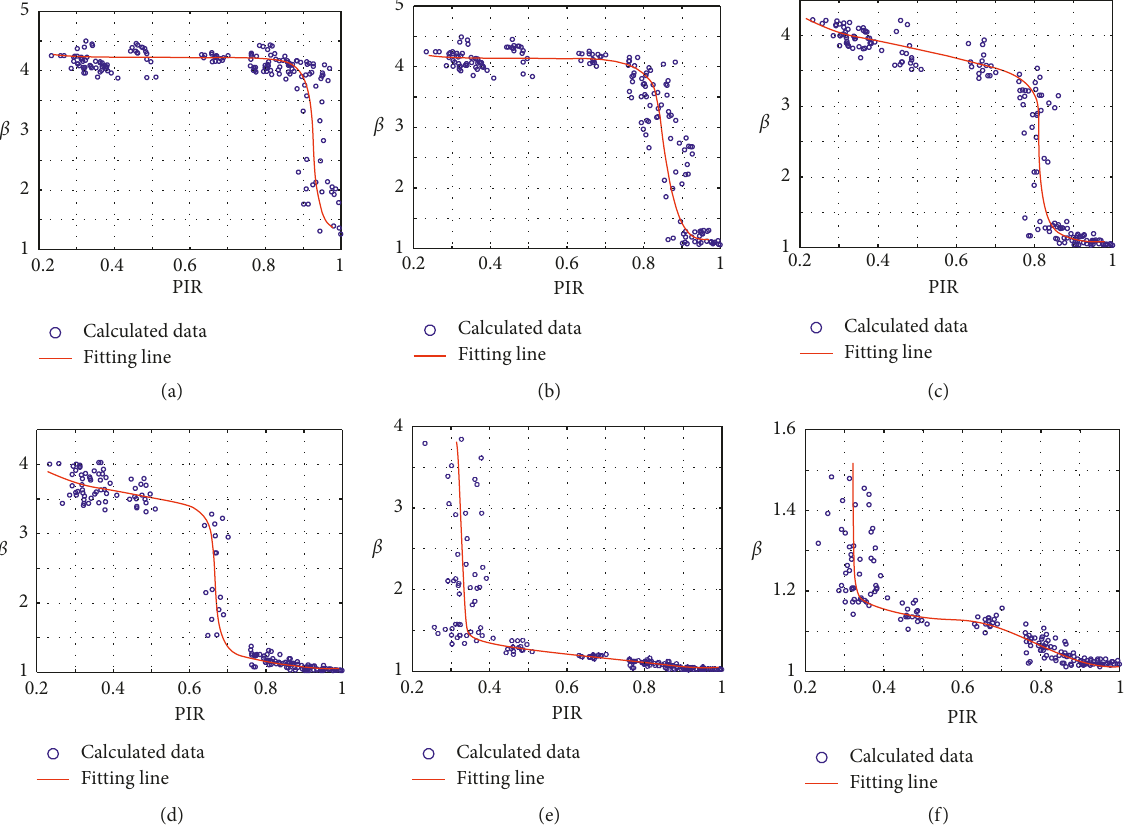
Figure 4: Compensation effects of AO systems with different DMs: (a) 19 actuators, (b) 37 actuators, (c) 61 actuators, (d) 91 actuators, (e) 127 actuators, and (f) 169